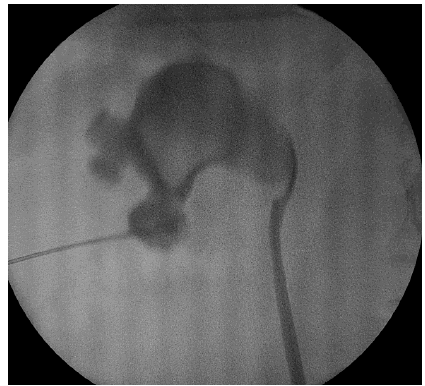
Figure 2. Percutaneous renal access.